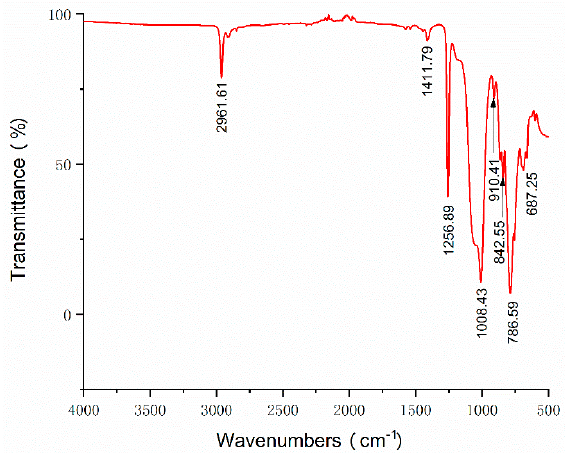
Figure 3. FT-IR spectra of the MWCNT/PDMS composite (MWCNT concentration 4 wt%).